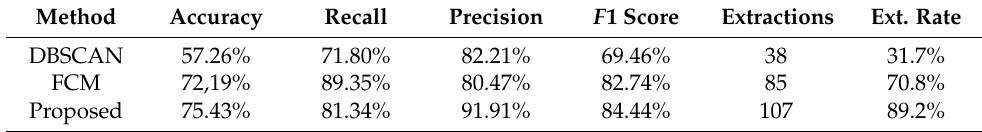
Table 1. Overall performance results (120 cases). Colored, statistically significant ( p < 0.05).